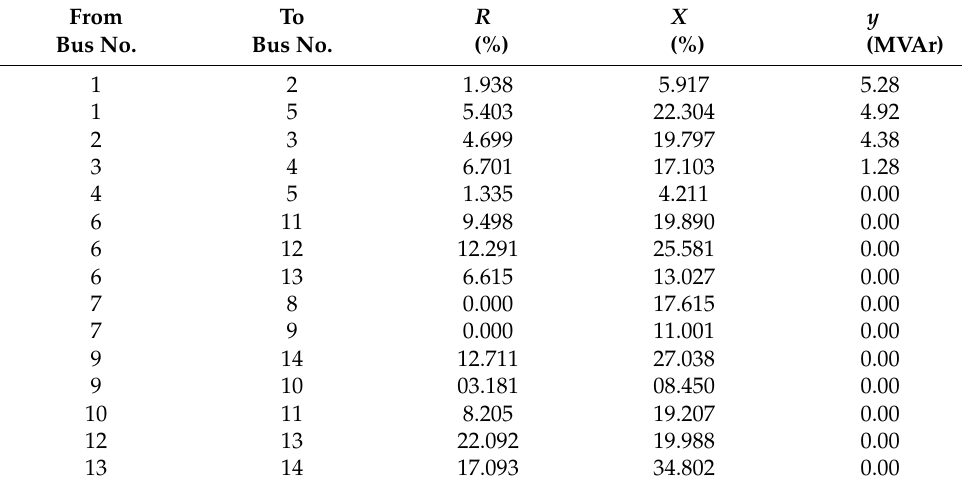
Table 8. Parameters of transmission lines and transformers.